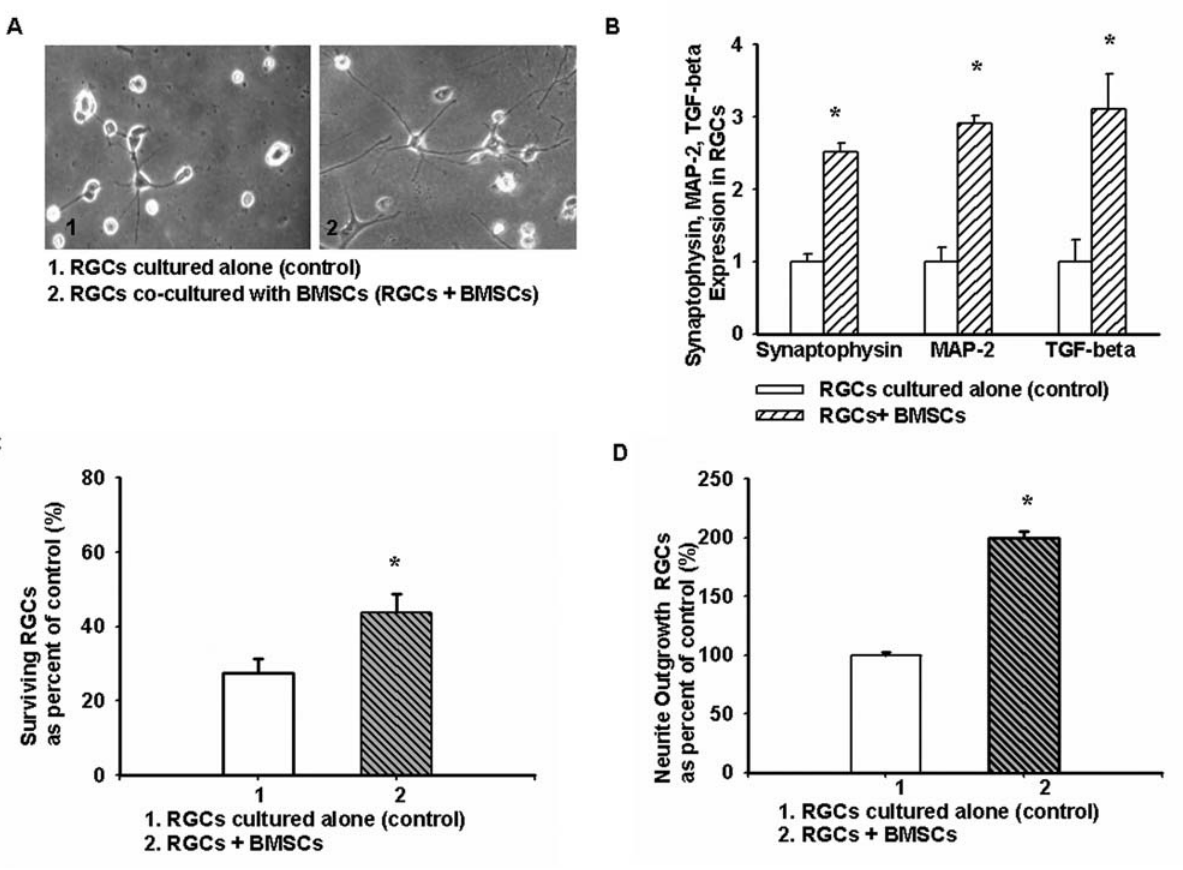
Figure 2. The effect of BMSCs on RGCs. A , RGC neurite formation was enhanced after 5 days of co-culturing with BMSCs (10 6 ). B , Synaptophysin, MAP-2 and TGF- b expression were up-regulated in RGCs co-cultured with BMSCs as determined by real-time RT-PCR (p=0.031, p=0.023, p=0.015, respectively). C , RGC survival was increased when co-cultured with BMSCs (p=0.025) (d) The mean outgrowth of neurites in RGCs co-cultured with BMSCs increased (p=0.03). *p-values # 0.05. (10 pictures were taken randomly under a regular microscope from culturing cells at different time points. The average relative percent of surviving and outgrowth of RGCs come from at least three separate experiments).